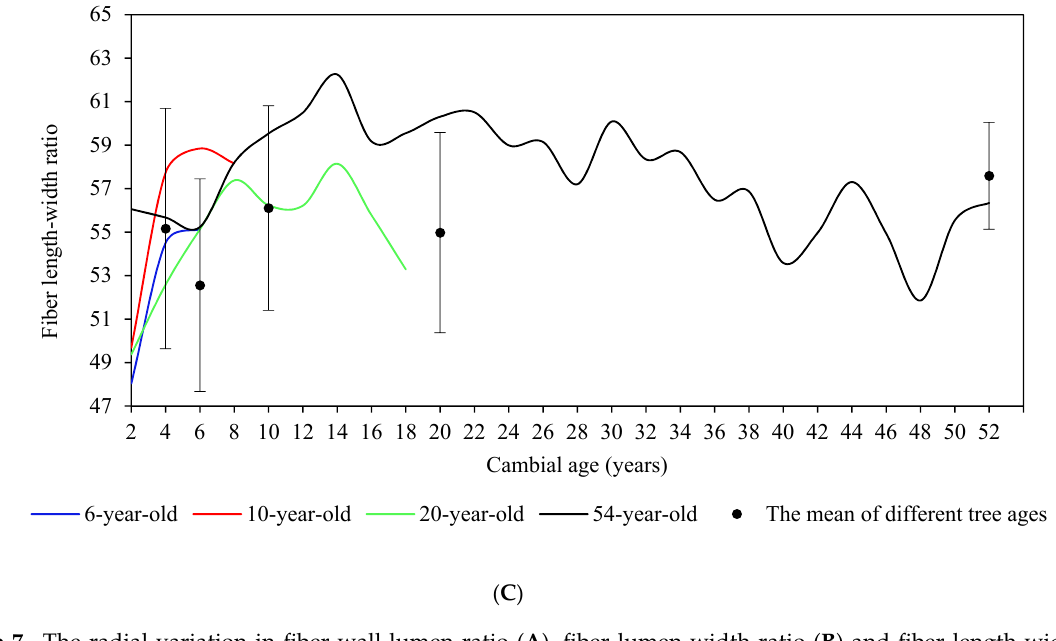
Figure 7. The radial variation in fiber wall-lumen ratio ( A ), fiber lumen-width ratio ( B ) and fiber length-width ratio ( C ) versus cambial age and the mean of differently aged S. superba .